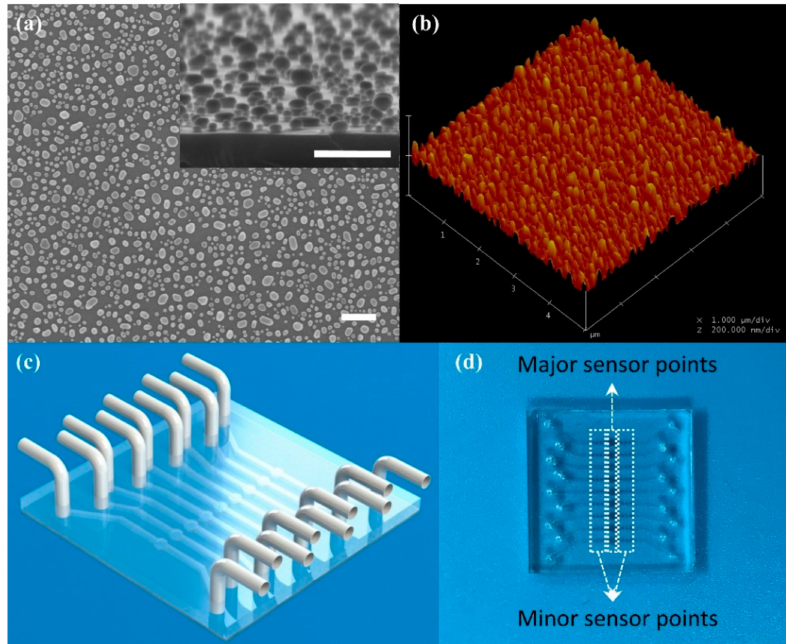
Figure 1. Schematic of the chip integrated with the microfluidic channel and picture of AuNPs. ( a ) The SEM (scanning electron microscope) image of AuNPs on a silicon substrate. Insert Figure: side view of AuNPs on a silicon substrate. Scale bar: 300 nm; ( b ) The AFM (atomic force microscope) image of AuNPs; ( c ) Schematic of the microfluidic chip; ( d ) The real picture of the